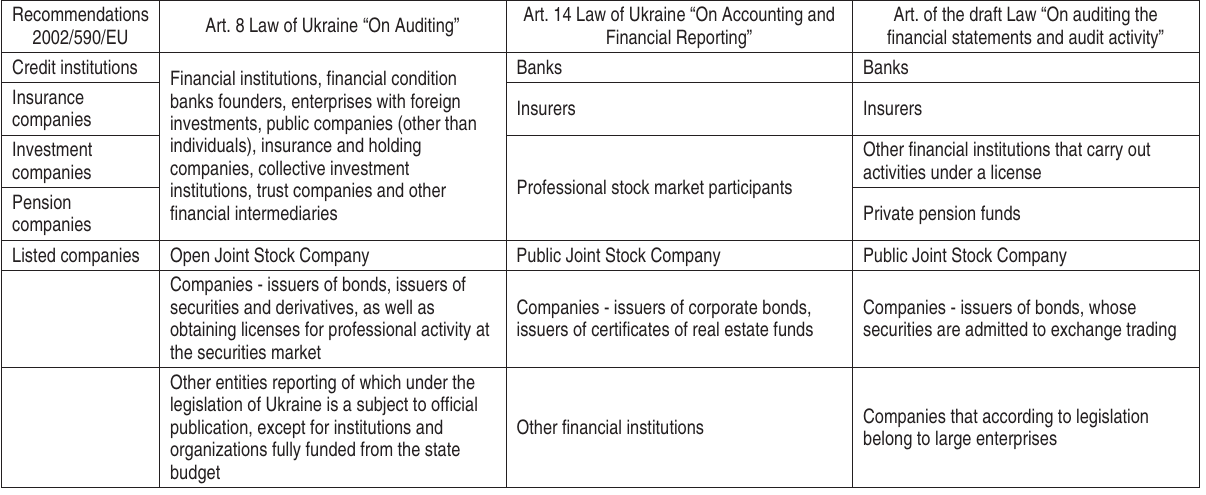
Table 1. Legislative approaches to the definition of